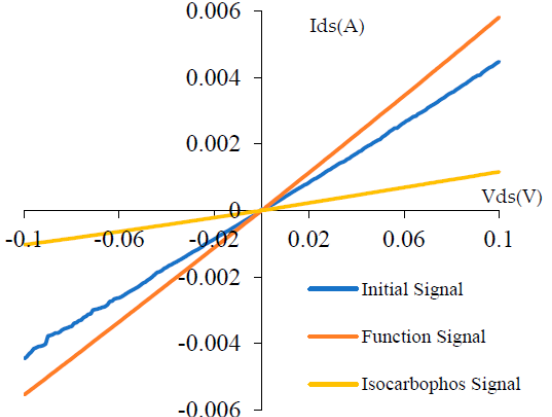
Figure 8. I − V curves corresponding to the initial signal, and the signal after thiolation, AChE func- tionalization.